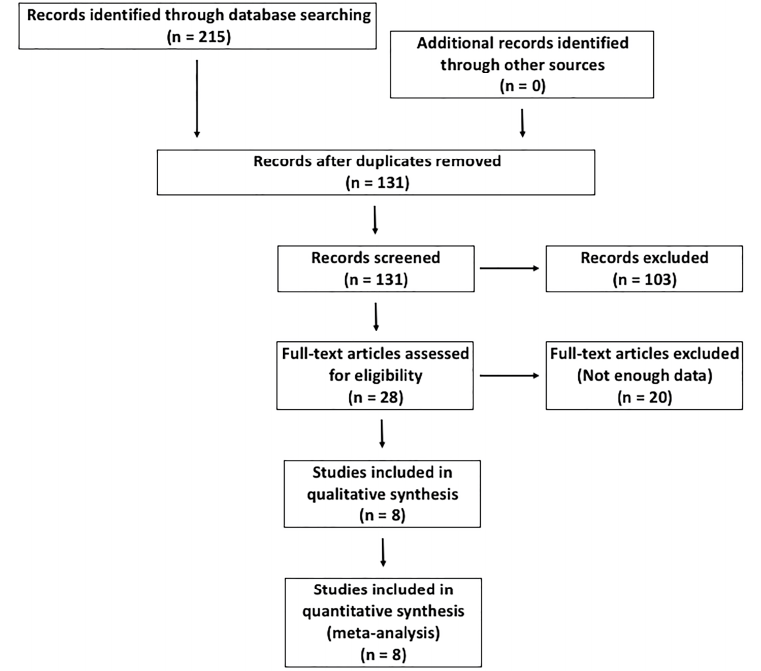
Figure 1. Flow chart of the studies selected for inclusion in the meta-analysis.